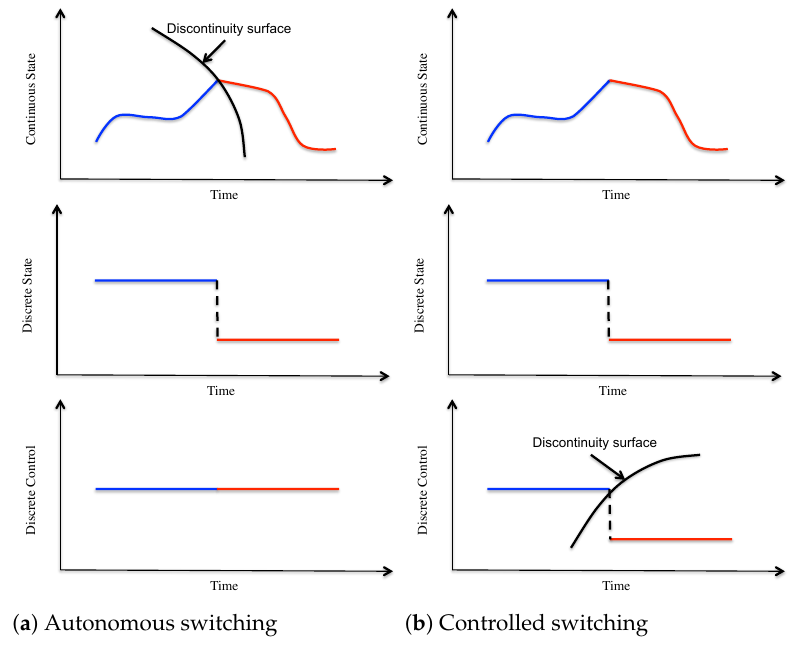
Figure 1. Illustration of switching discrete